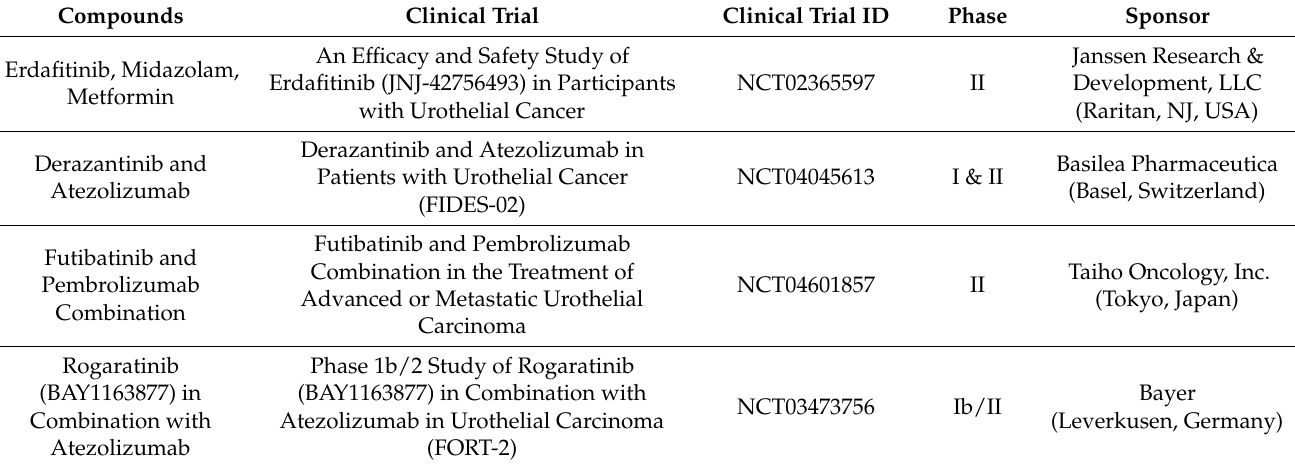
Table 1. Current combination therapy involving FGFR inhibitors in bladder